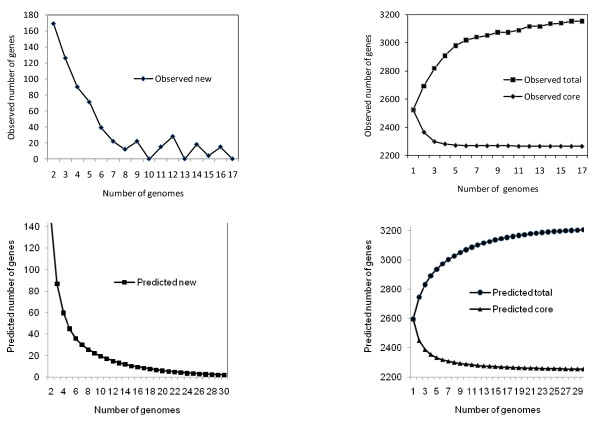
Comparison of the observed and predicted supragenome parameters as additional strains are sequenced. The two panels on the left show observed (upper panel) and predicted (lower panel) numbers of new genes that were or would be found in the second to the nth genome for the number of strains examined (17) or a hypothetical study of 30 strains of Staphylococcus aureus. The two panels on the right show observed (upper panel) and predicted (lower panel) numbers of core and total genes that were or are predicted to be found in second to the nth genome for the number of strains examined (17) or a hypothetical study of 30 strains of Staphylococcus aureus. Observed new, core, and total genes were calculated using genomes examined in ascending order of their counts of non-core genes.